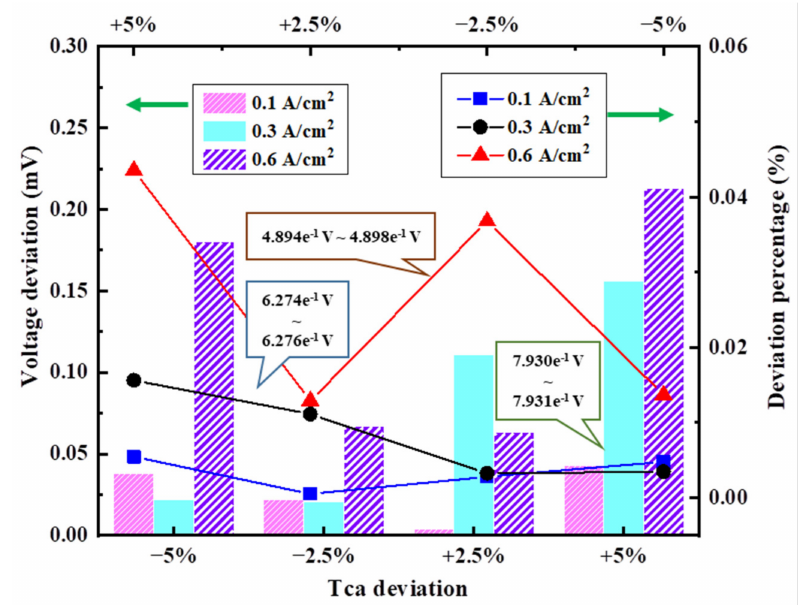
Figure 10. Impacts of CIT deviations on the voltage deviations and their corresponding percentages under three current